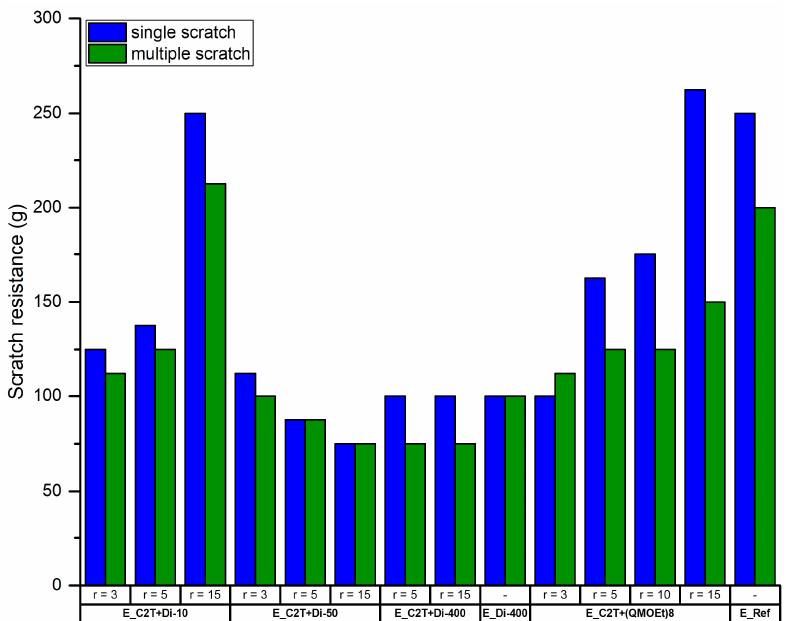
Figure 12. Scratch resistance of commercial coating E_Ref and elastomer films prepared via the reaction between C2T and Di-10, Di-50, Di-200, and (QM OEt ) 8 , respectively. Film thickness was ~100 µm.